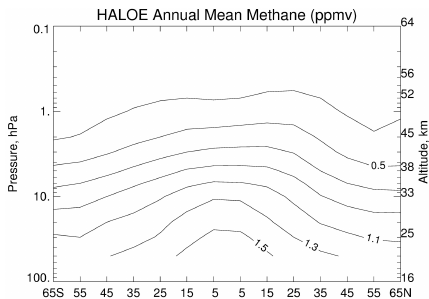
Figure 4. Annually averaged, zonal mean HALOE methane from the MLR analyses (contour interval is